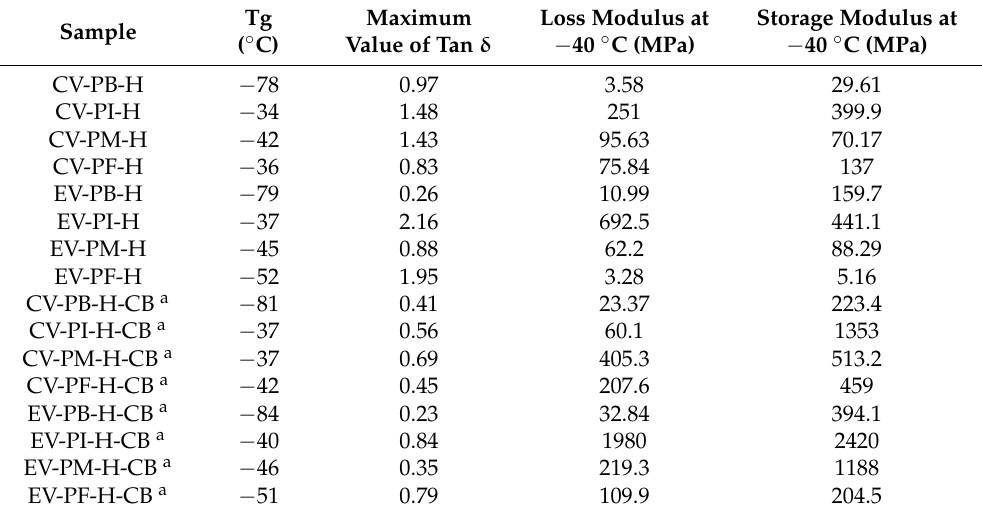
Storage and loss modulus at − 40 ◦ C, T g , and Tan δ (maximum value) of the crosslinked